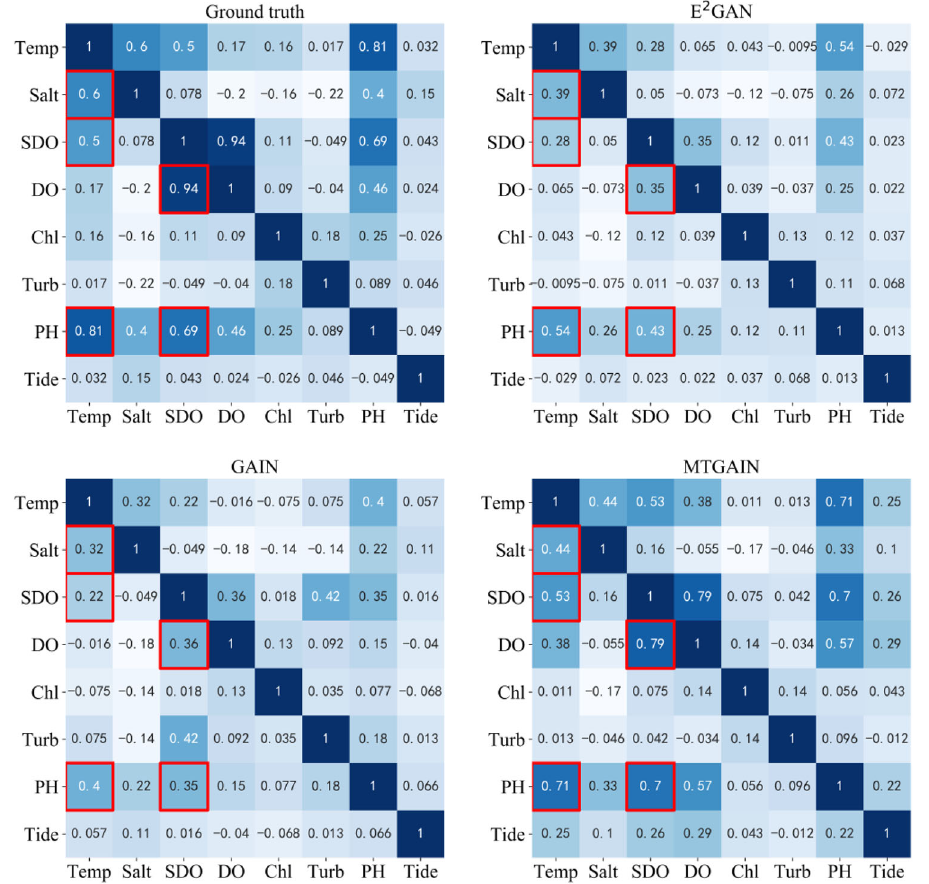
Fig. 5 The PCCs between different attributions reconstructed by different methods under 50% missing